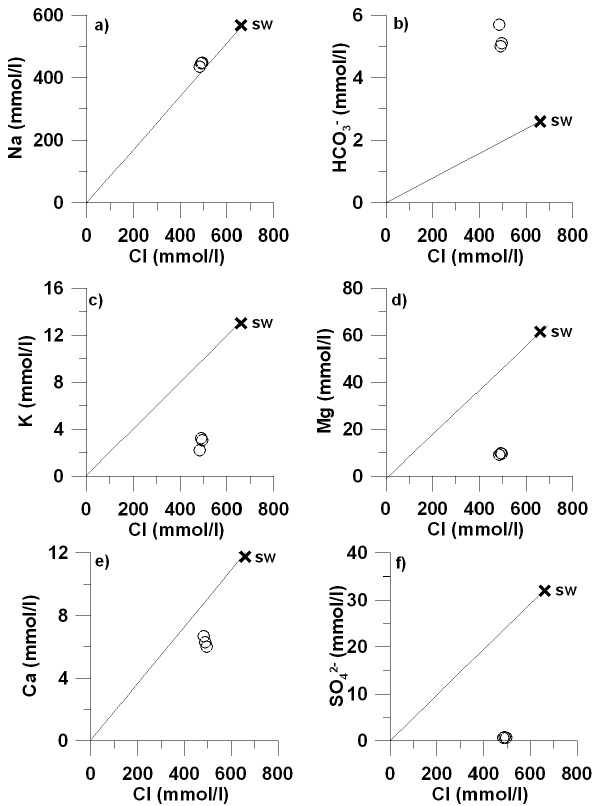
Fig. 8. Plots of major and minor constituent vs. Cl. Na (a) , alka- linity (b) , K (c) , Mg (d) , Ca (e) and SO 4 (f) . Mixing line between freshwater and Mediterranean seawater is also reported.